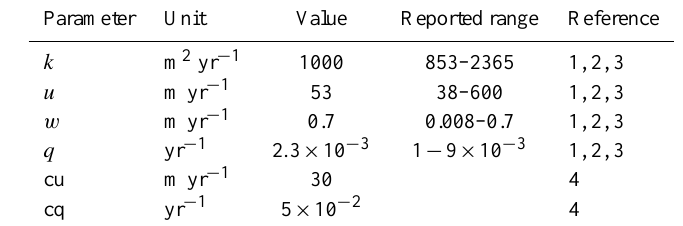
Table 4. Transport